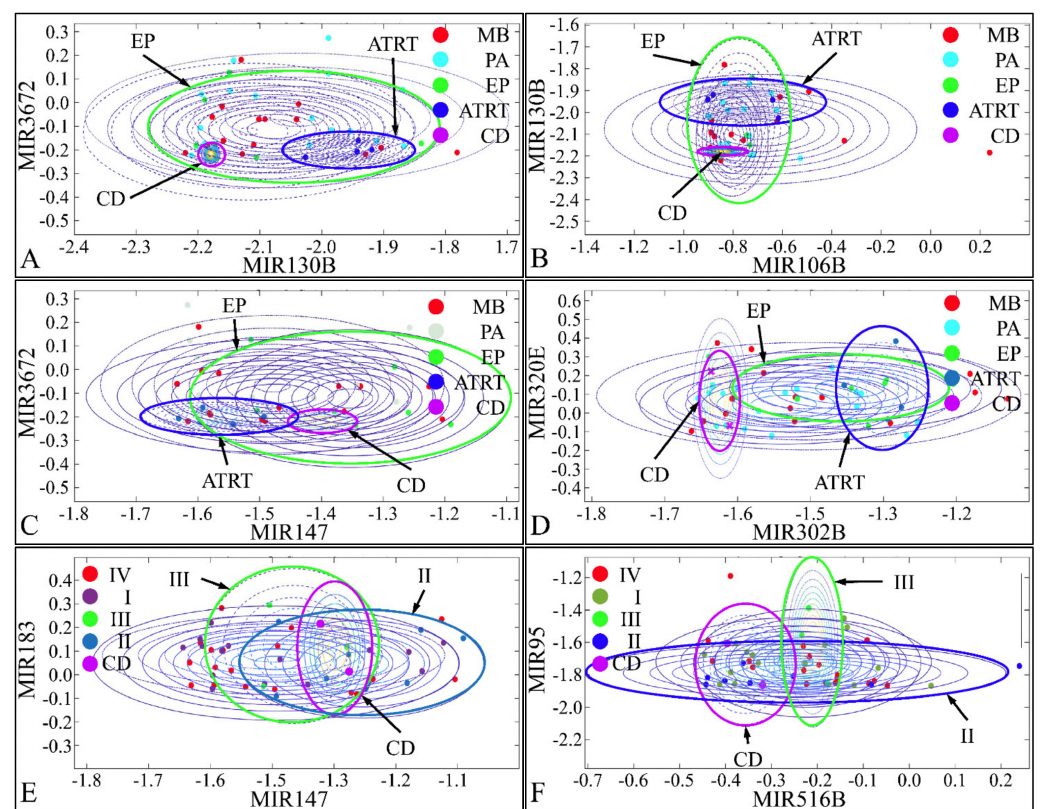
Figure 16. Naïve-Bayes classification. Pairs of miRNAs were tested for their classification potential using naïve-Bayes classifiers. miR-130b and miR-3672 ( A ), miR-106b and miR-130b ( B ), and miR-147 and miR-3672 ( C ) were able to discrim- inate between CD, ATRT, and EP. Similarly, miR-302b and miR-320e ( D ), miR-147 and miR-183 ( E ), and miR-516b and miR-95 ( F ) were able to discriminate between CD, tumor grade II, and tumor grade III (Legend: CD: Cortical dysplasia; EP: Ependymoma; CD: Cortical dysplasia; PA: Pilocytic astrocytoma; MB: Medulloblastoma; ATRT: Atypical teratoid rhabdoid tumor).